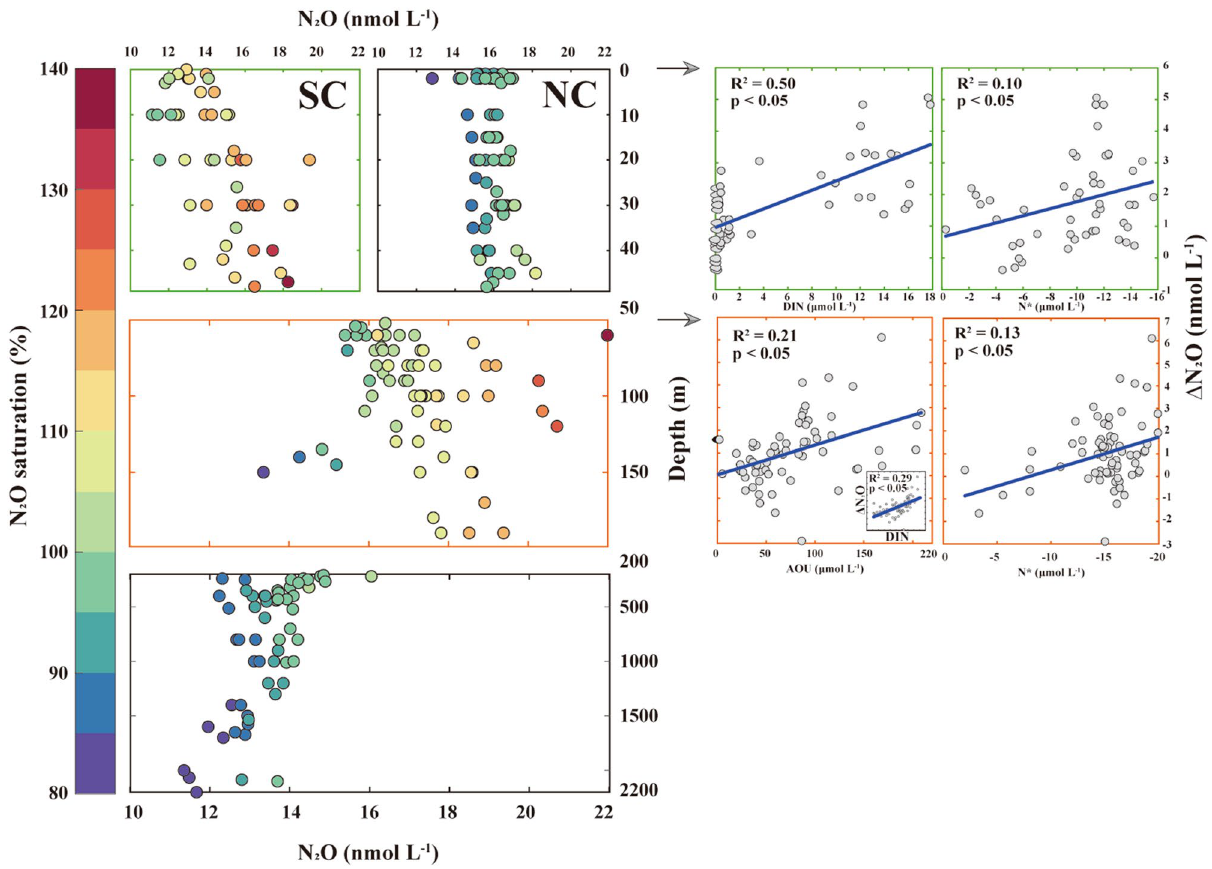
Figure 2. Vertical distribution of N 2 O measured in the WAO water column during the summer of 2017 with saturation levels (N 2 O sat (%) = (N 2 O measured /N 2 O eq ) × 100; blue to red gradient color bar). Based on the vertical composition of water masses in the study area (surface, Pacific summer water and fresh water; intermediate, Pacific Winter Water; and deep areas, Atlantic Water and Arctic Bottom Water), we represent the vertical N 2 O distribution by dividing into three layers (i.e., surface, 0–50 m; intermediate, 50–200 m; and deep layer, 200– 2200 m). To show contrasting values associated with saturation levels (%), the surface layer is shown separately for SC and NC. To investigate the potential sources of biogeochemically derived N 2 O (ΔN 2 O) production, the figures on the right-hand side show the correlations of ΔN 2 O with DIN and N * in the surface layer of the SC (green color boxes), and with AOU and N * in the intermediate layer (orange color boxes), including statistical information (R 2 and p values). The inset shows the correlation between ΔN 2 O and DIN in the intermediate layer. Note that this figure was generated using MATLAB program (ver. R2019b and www. mathw orks.